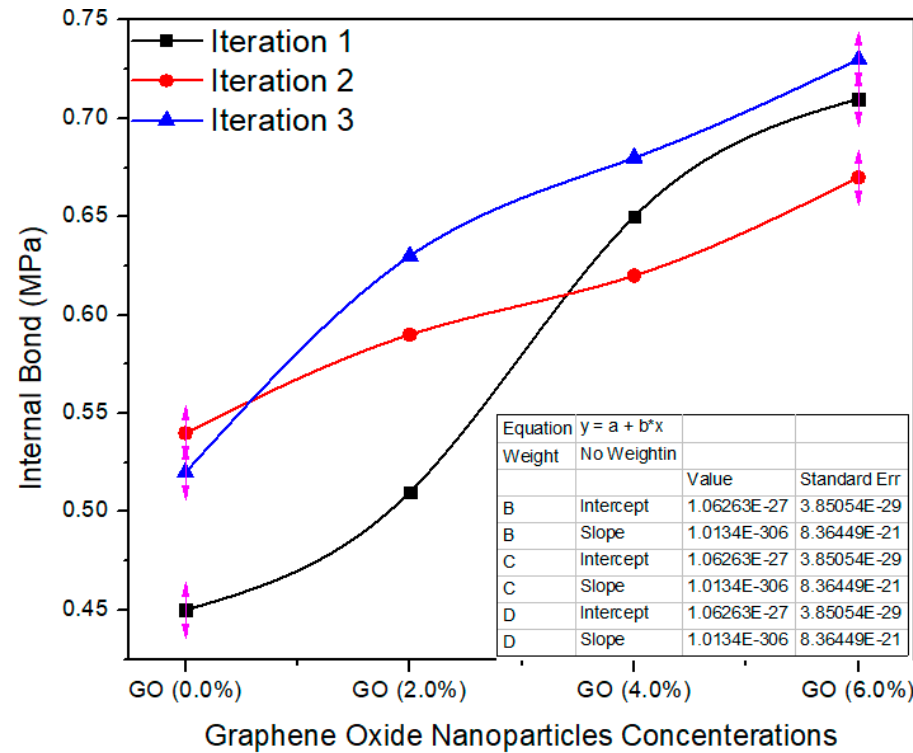
Figure 12. Internal bond values of different counts of GO.